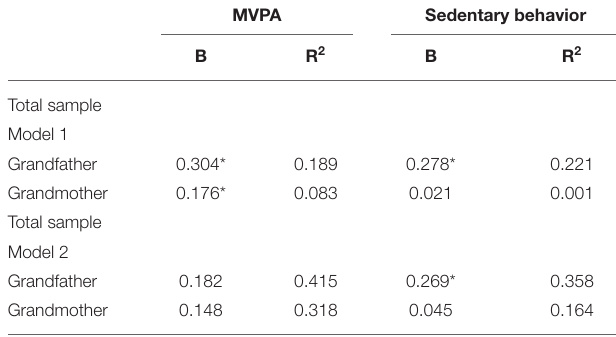
Model 1: Unadjusted. Model 2: Adjusted for age, BMI and